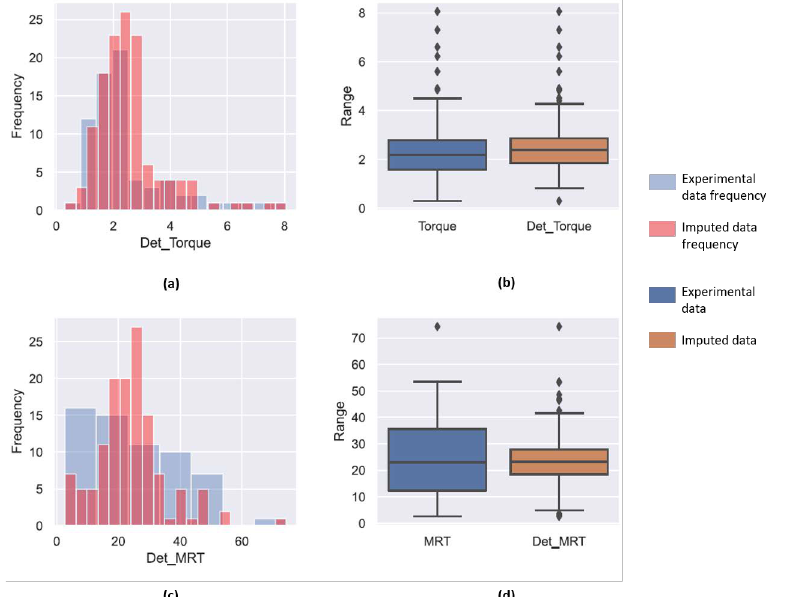
Figure 1. ( a , c ) compare the frequency of occurrence of each value of torque and MRT, respectively. The blue bar in the plot represent the experimental values while the red bars represent the values pre- dicted by the regression model. A higher overlap indicates a regression model with good prediction accuracy. ( b , d ) are box plots comparing the median values as well as the range of experiments to the median and range obtained from the regression model for the torque and MRT, respectively. The diamond points represent points that lie beyond the statitical range.